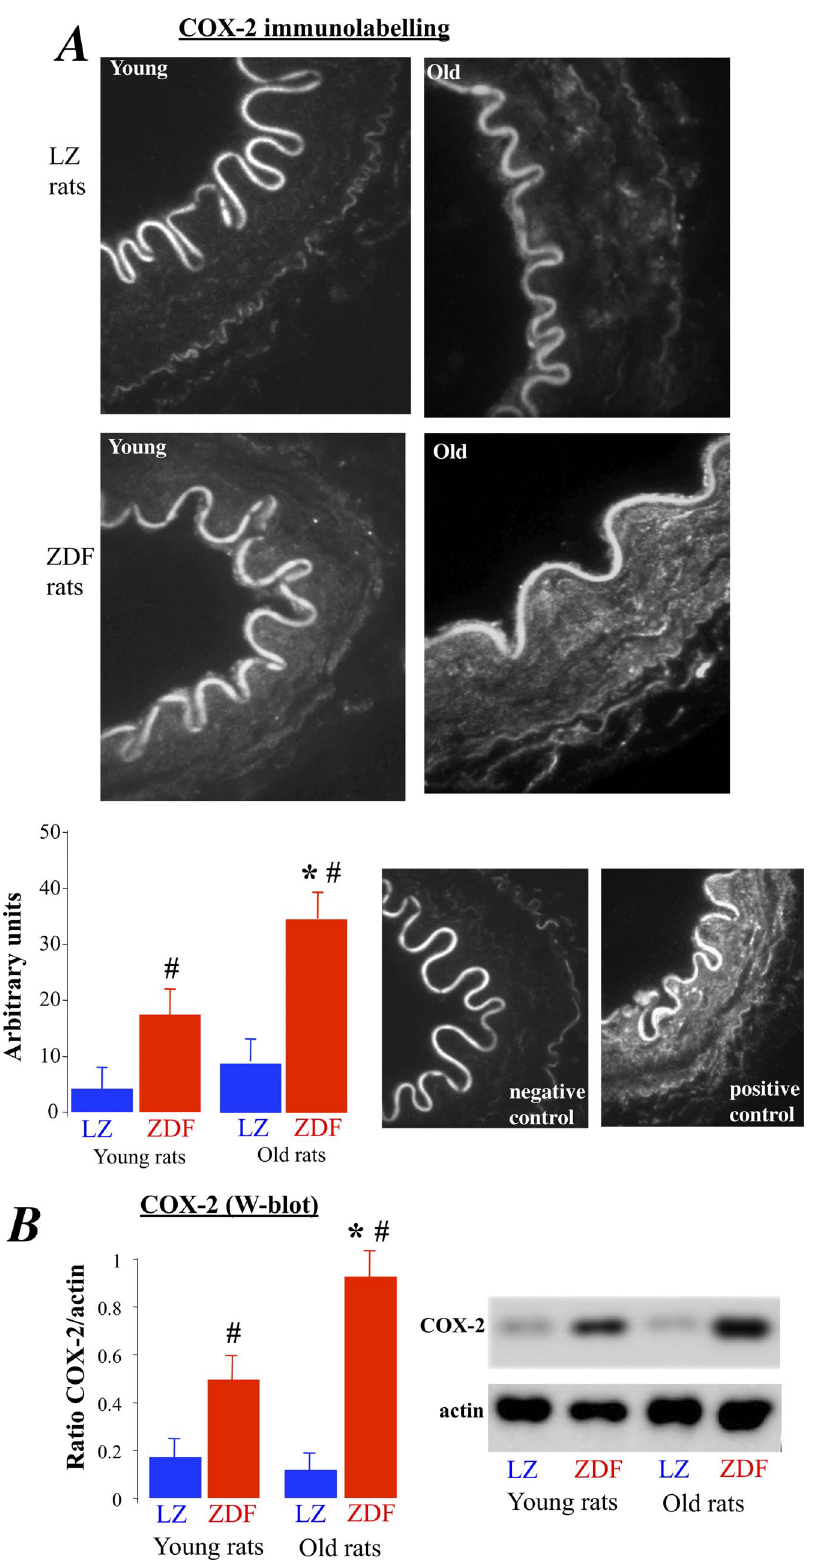
Figure 4. Measurement of COX-2 expression level in mesenteric resistance arteries isolated from young and old LZ and ZDF rats using immunolabelling (A) and Western-blot analysis (B). Mean 6 SEM is presented (n=10 per group). # P , 0.01, ZDF versus LZ. *P , 0.01, old versus young rats.